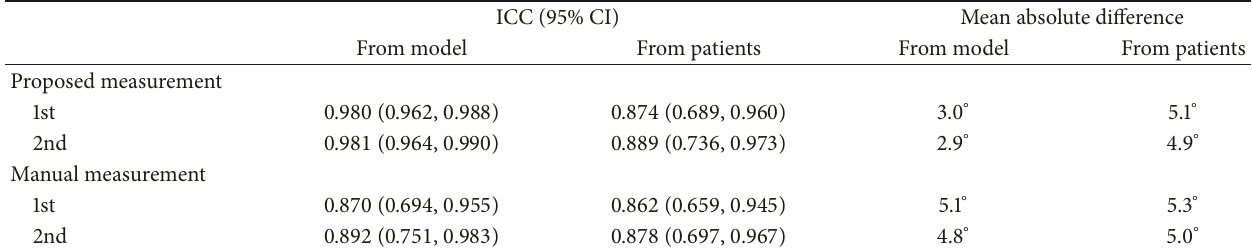
Table 2: Interobserver analyses.